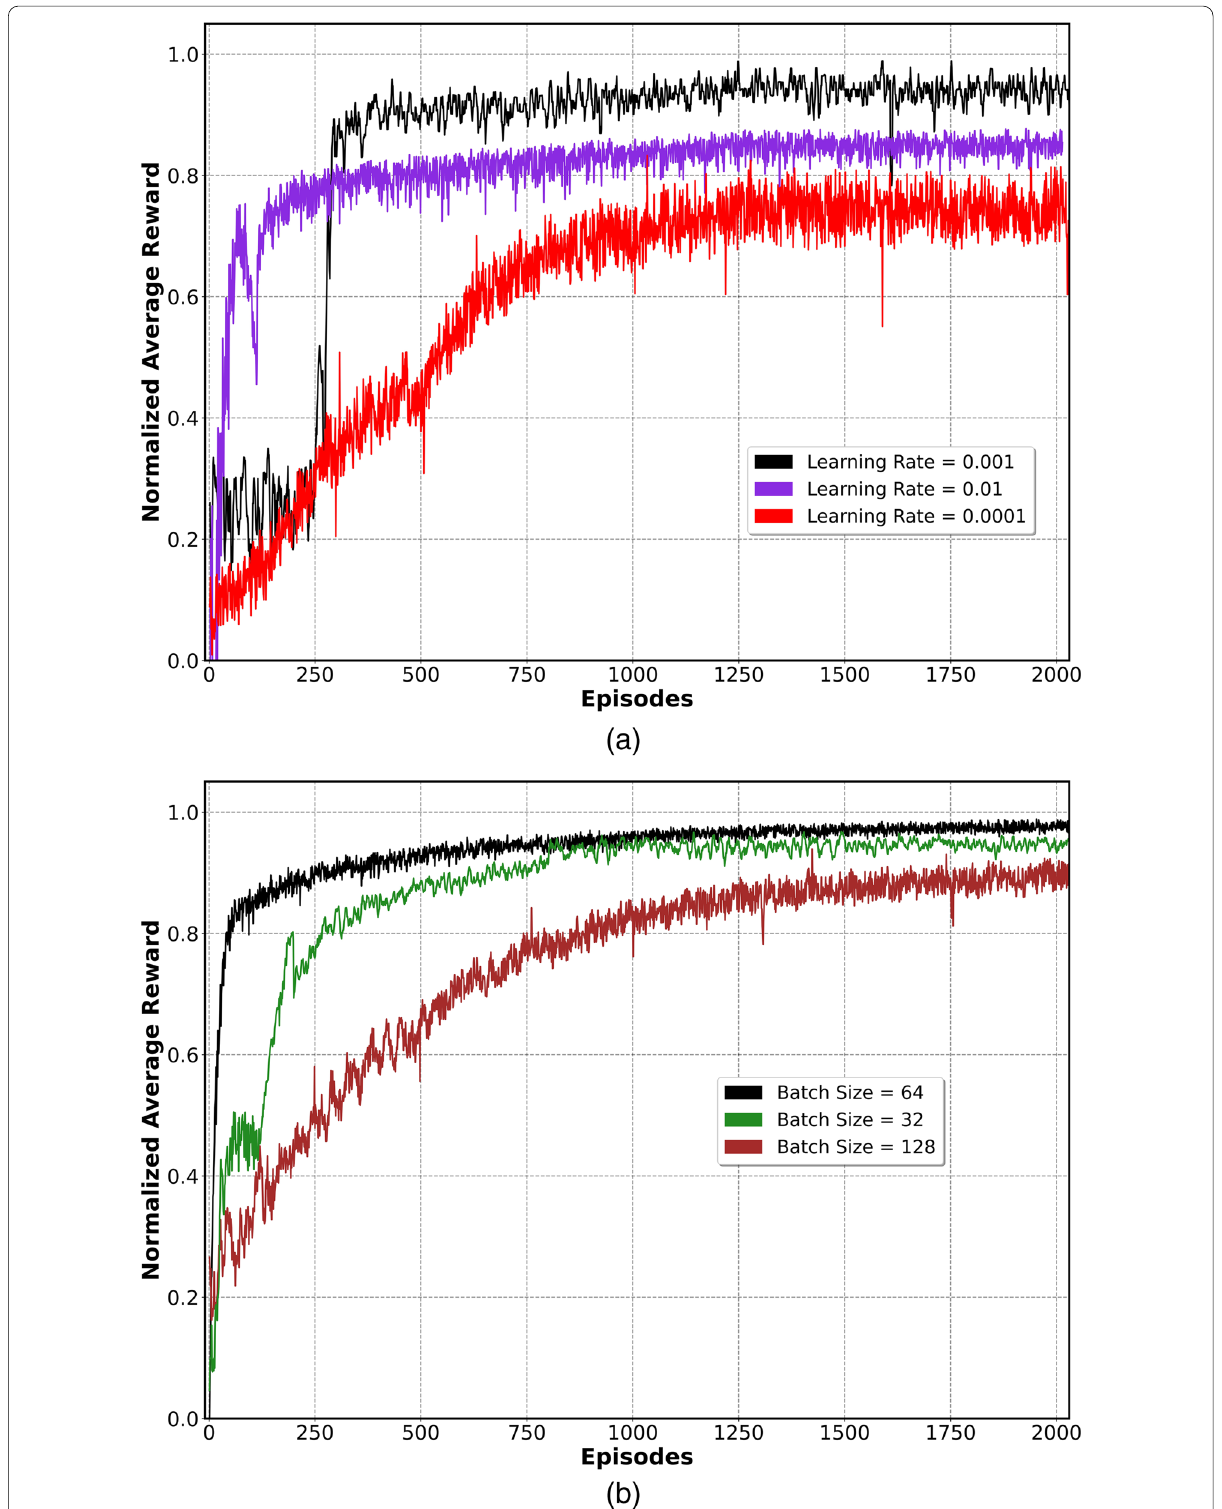
Fig. 3 Normalized average rewards of CMATD3 agent with ( a ) different learning rates and ( b ) different batch